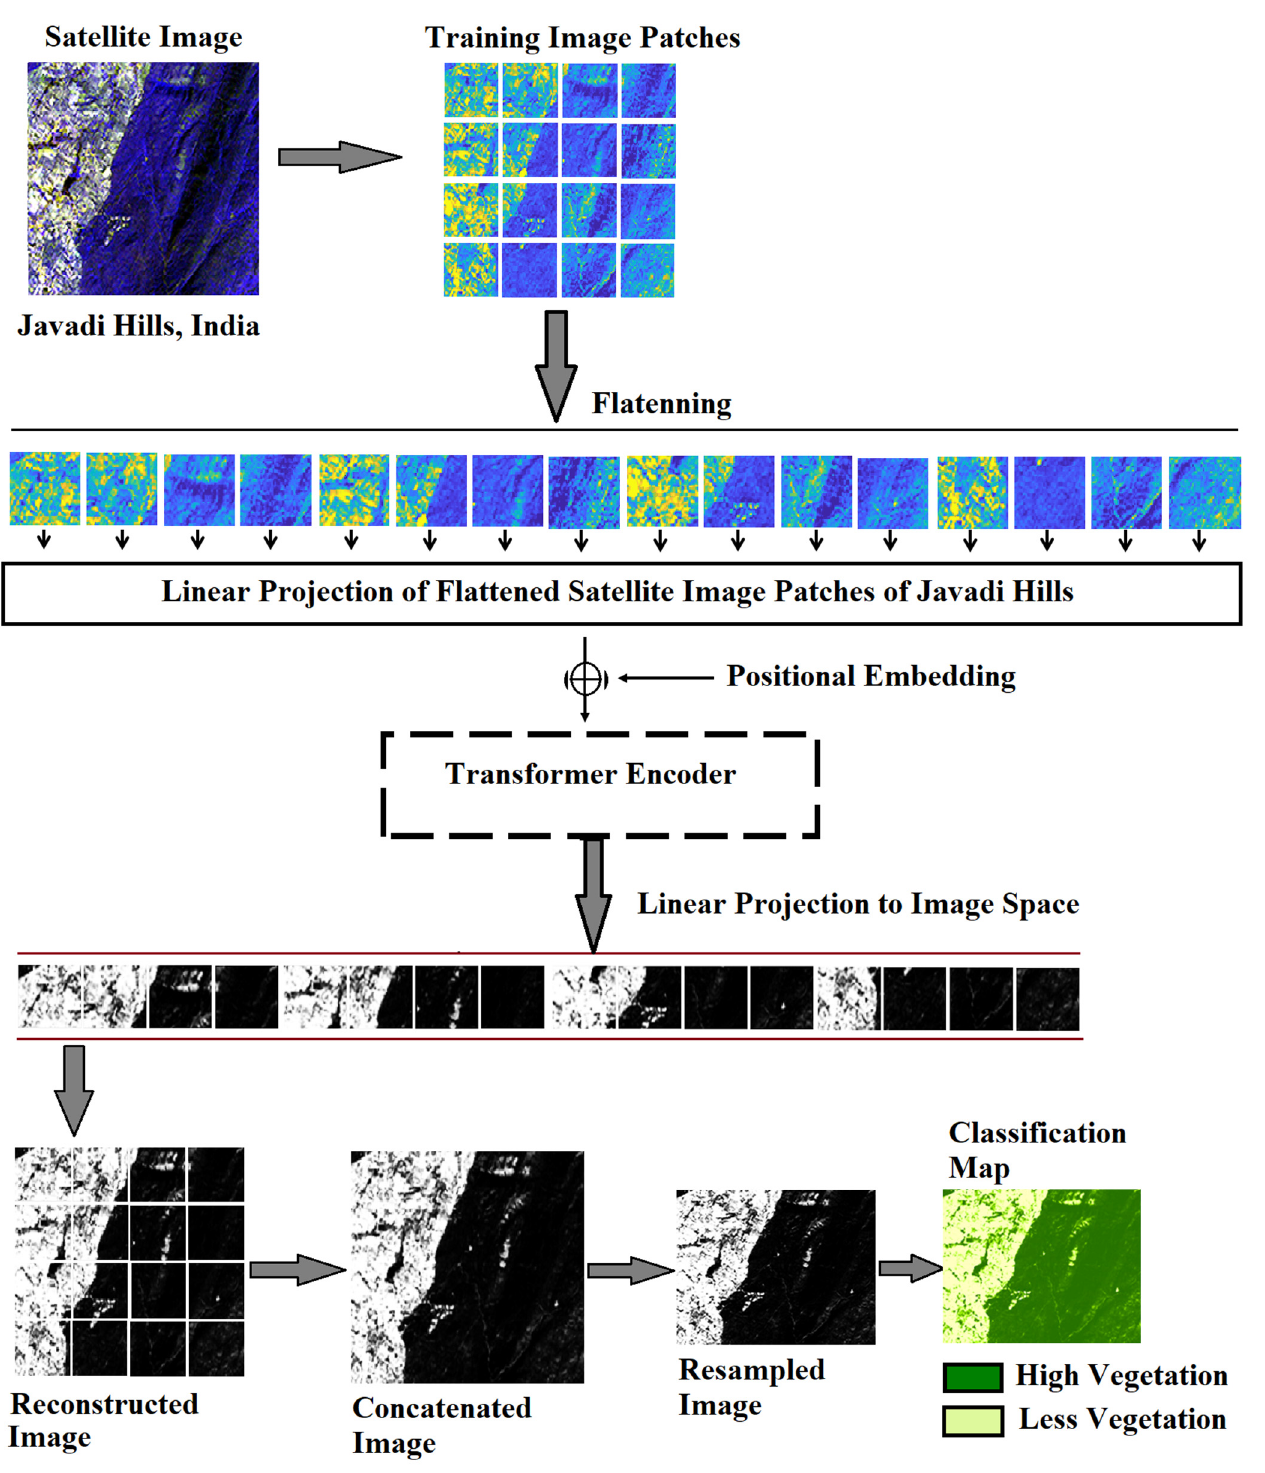
Figure 6. Proposed Vision Transformer model for LU/LC classification. Let S i represent a set of training satellite images, r , where X i is a satellite image; y i represents the class labels { y i ∈ 1, 2, . . . . . . , m } associated with the X i , and m denotes the number of defined LU/LC classes for that set.